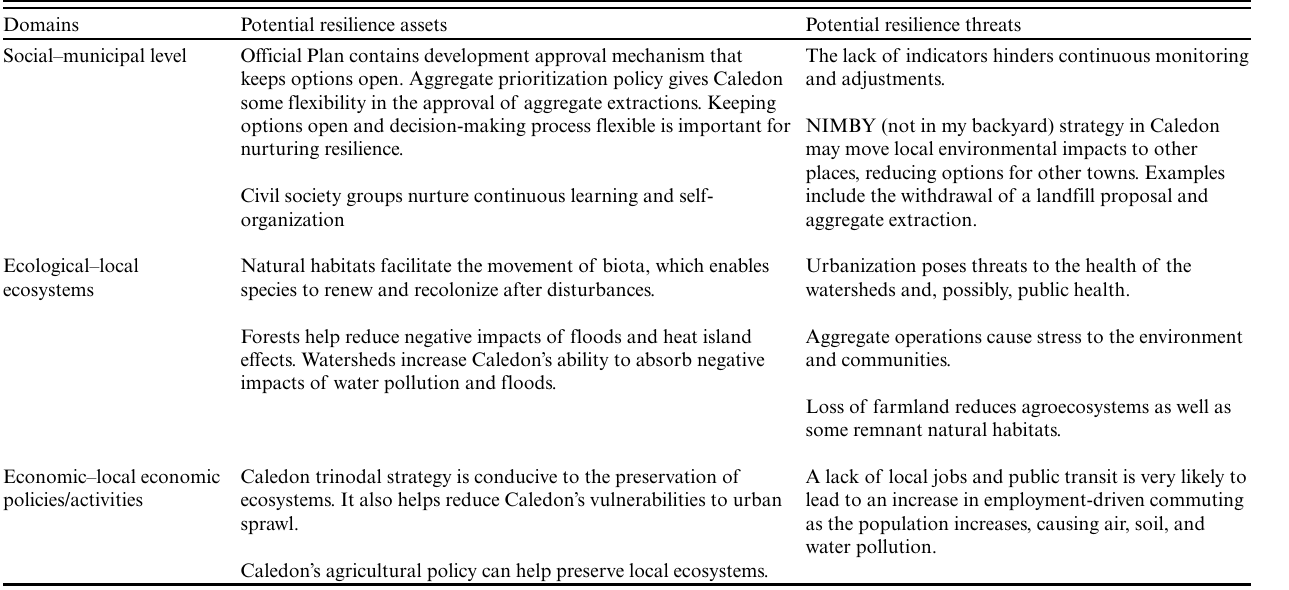
Table 6. A summary of potential assets and threats based on a cross-scalar study of Caledon